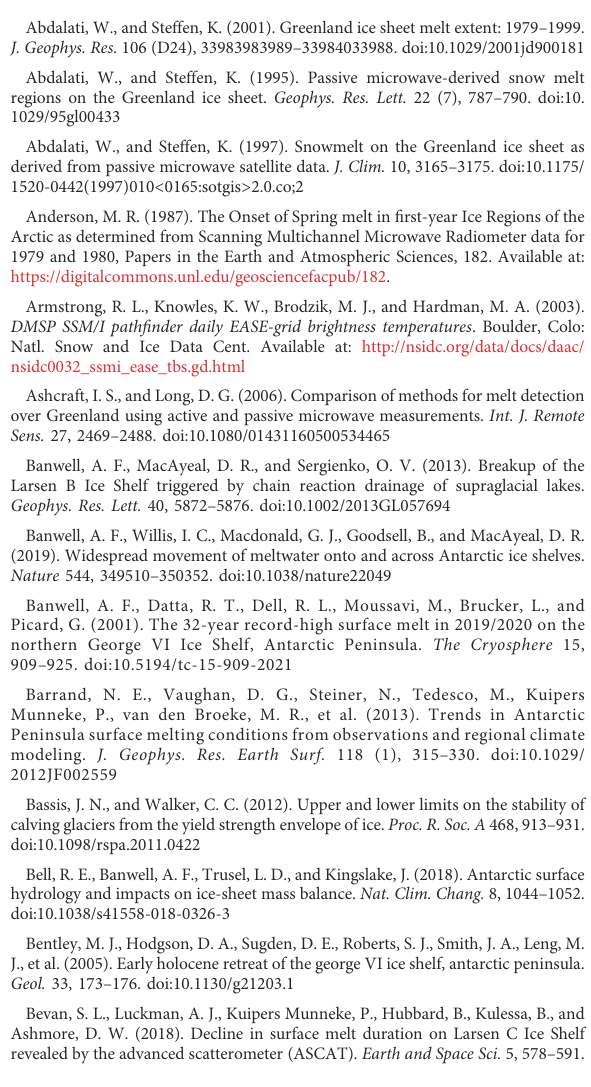
SUPPLEMENTARY FIGURE S1 (A) Distribution of mean net heat fl ux, wind speed, and sea level pressure during astral summer; and (B) temperature advection across the Antarctic